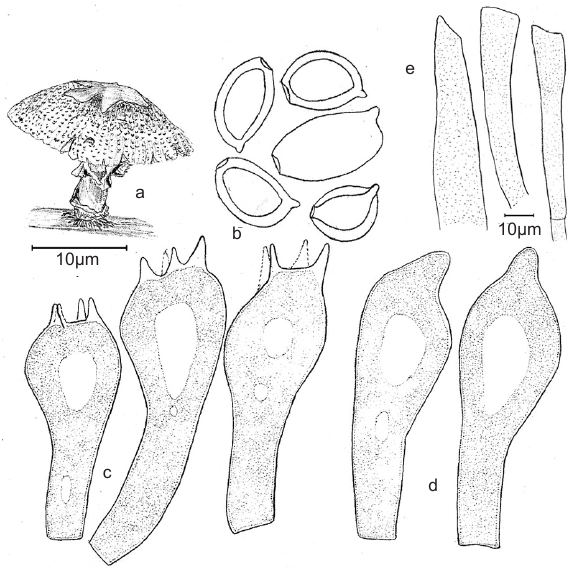
Figure 1. The location of collection area